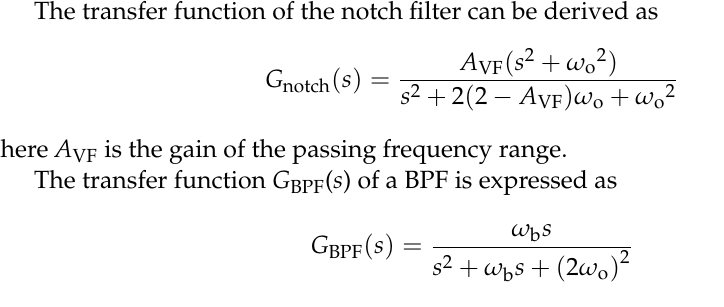
Figure 2. Introduction of virtual resistance and BPF. ( a ) Block diagram; ( b ) equivalent transfor-